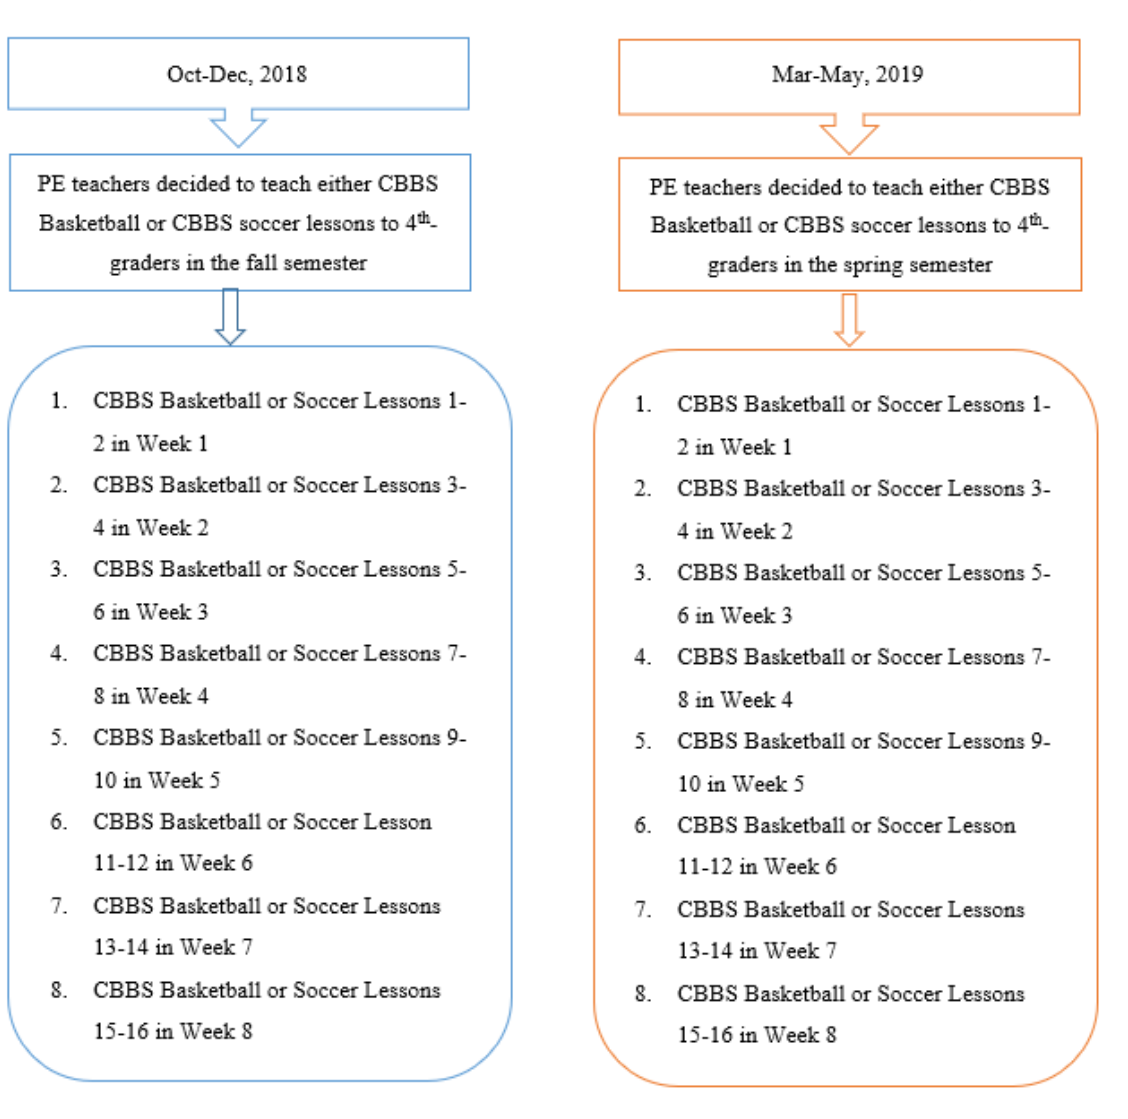
Figure 2. CBBS intervention protocols.